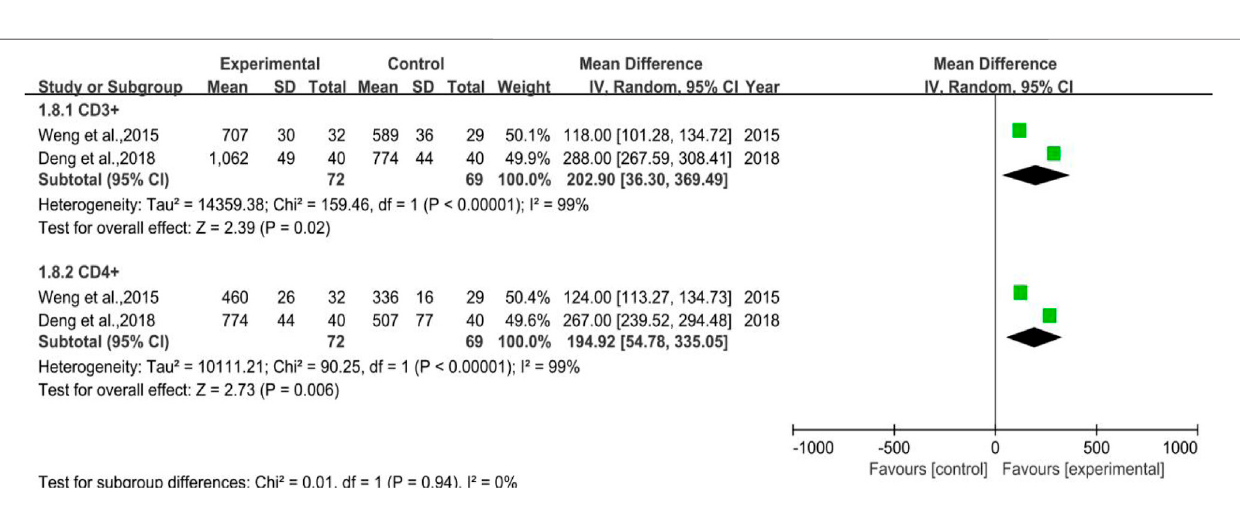
FIGURE 10 | The forest plot of CD3 + and CD4 + in preventive medication.